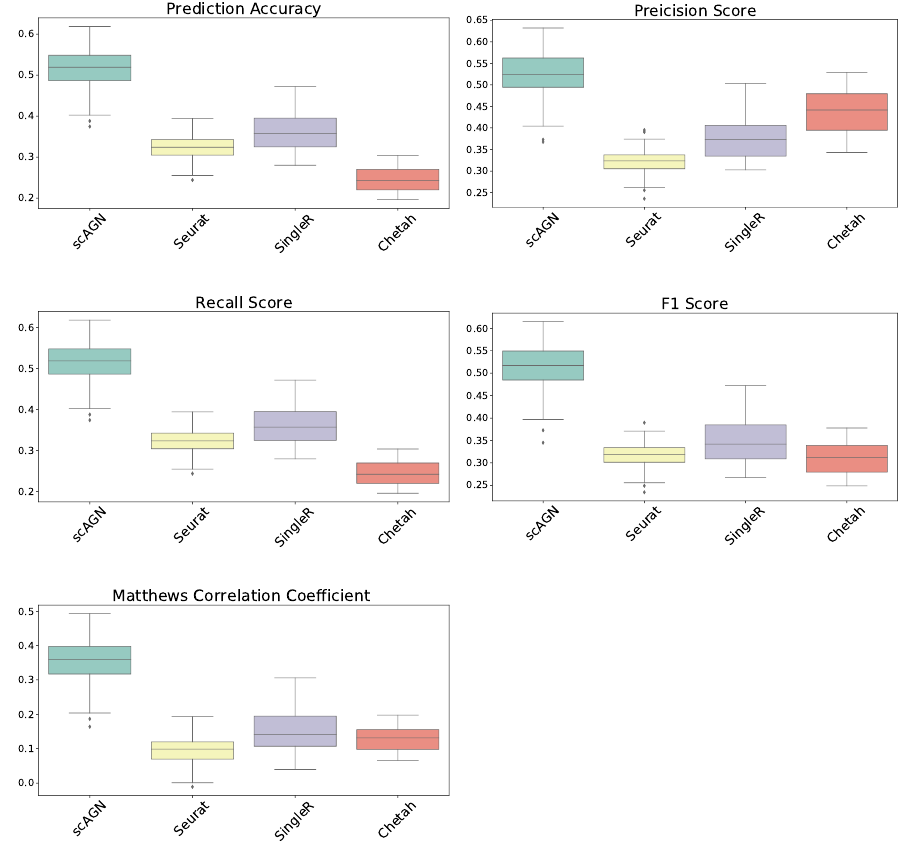
Figure 4. Boxplot to illustrate the performance of scAGN against other methods using simulated datasets with a sparsity of 95% (all four classes equiprobable). scMAP-cell and scMAP-cluster were not included in the plots as they failed for the